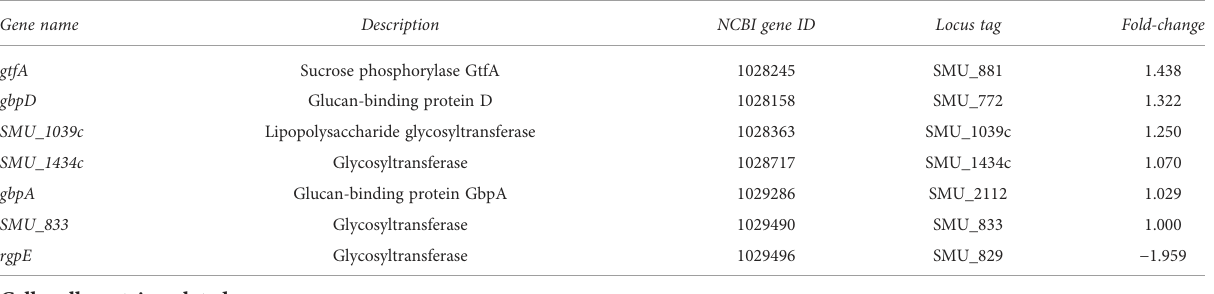
TABLE 5 List of genes showing no signi fi cant change in expression in strain SN74CND compared with parental strain SN74 by RNA-Sequencing. Cell surface protein-related